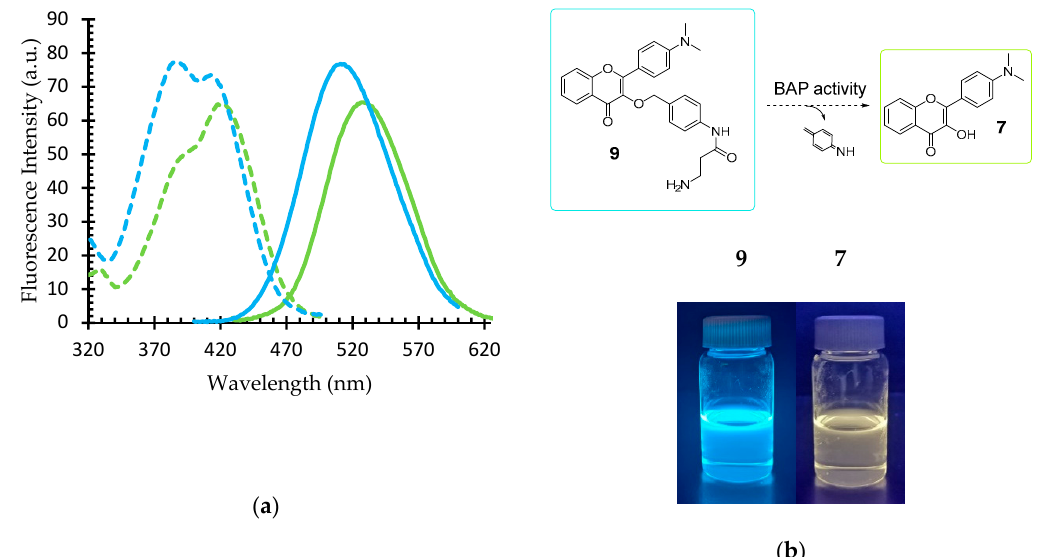
Figure 2. Fluorescence properties of BAP substrate 9 and fluorophore 7. ( a ) Fluorescence excitation (dashed line) and emission (solid line) of the substrate 9 (blue) and the enzymatic hydrolysis product, fluorophore 7 (green). ( b ) THF:water (1:1) solutions of 7 and 9 . Table 1. Excitation and emission maxima and Stokes shifts for BAP substrate 9 and fluorophore 7 . λ ex (nm) λ em (nm) Stokes Shift